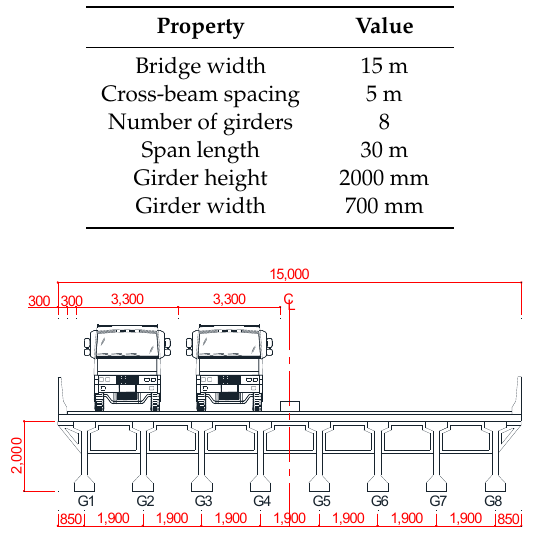
Figure 1. Cross-section of the PSC-I bridge at the mid-span (mm).